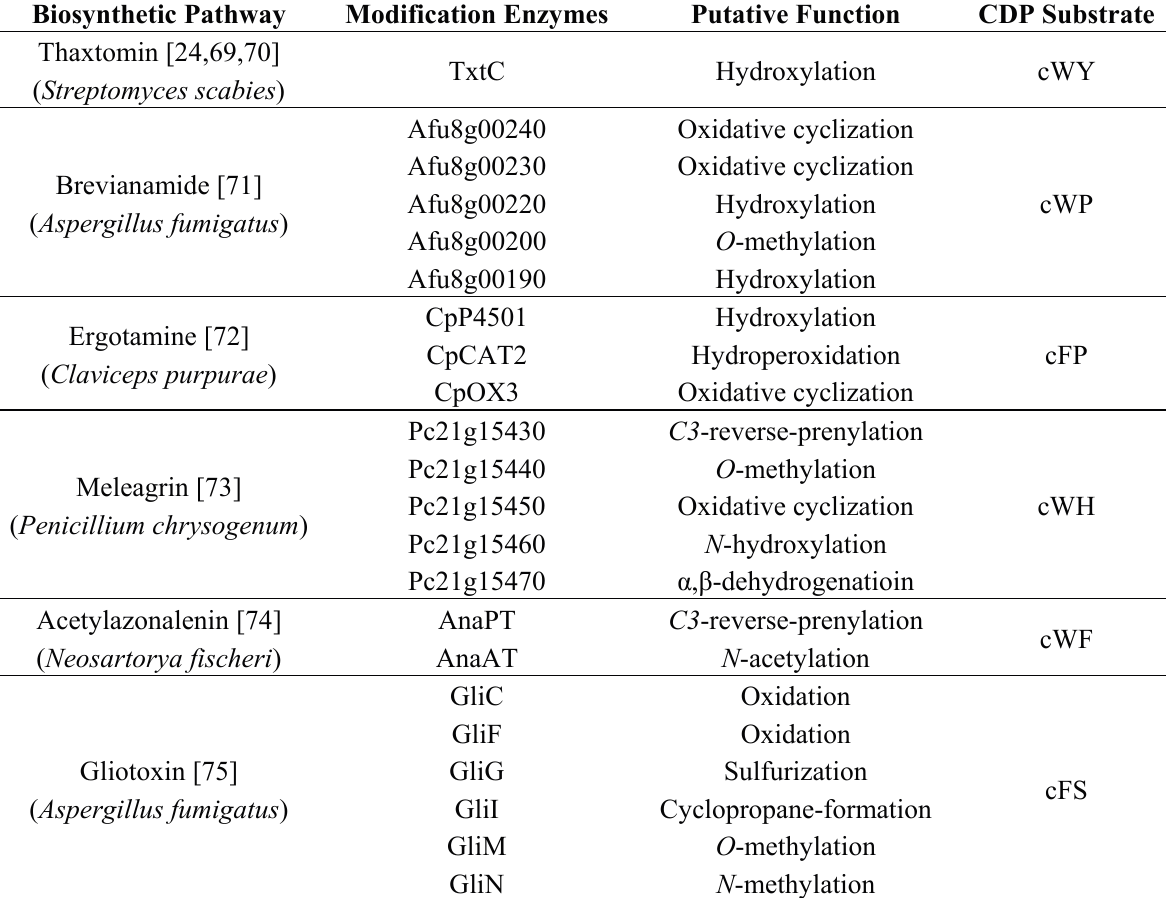
Table 1. Exemplary selection of NRPS (nonribosomal peptide synthetases) pathways generating cyclic dipeptide (CDP)-containing natural products. Shown are the different modification enzymes found inside those gene clusters, their putative function as well as the substrate CDP-scaffold used by those enymes. Biosynthetic Pathway Modification Enzymes Putative Function CDP